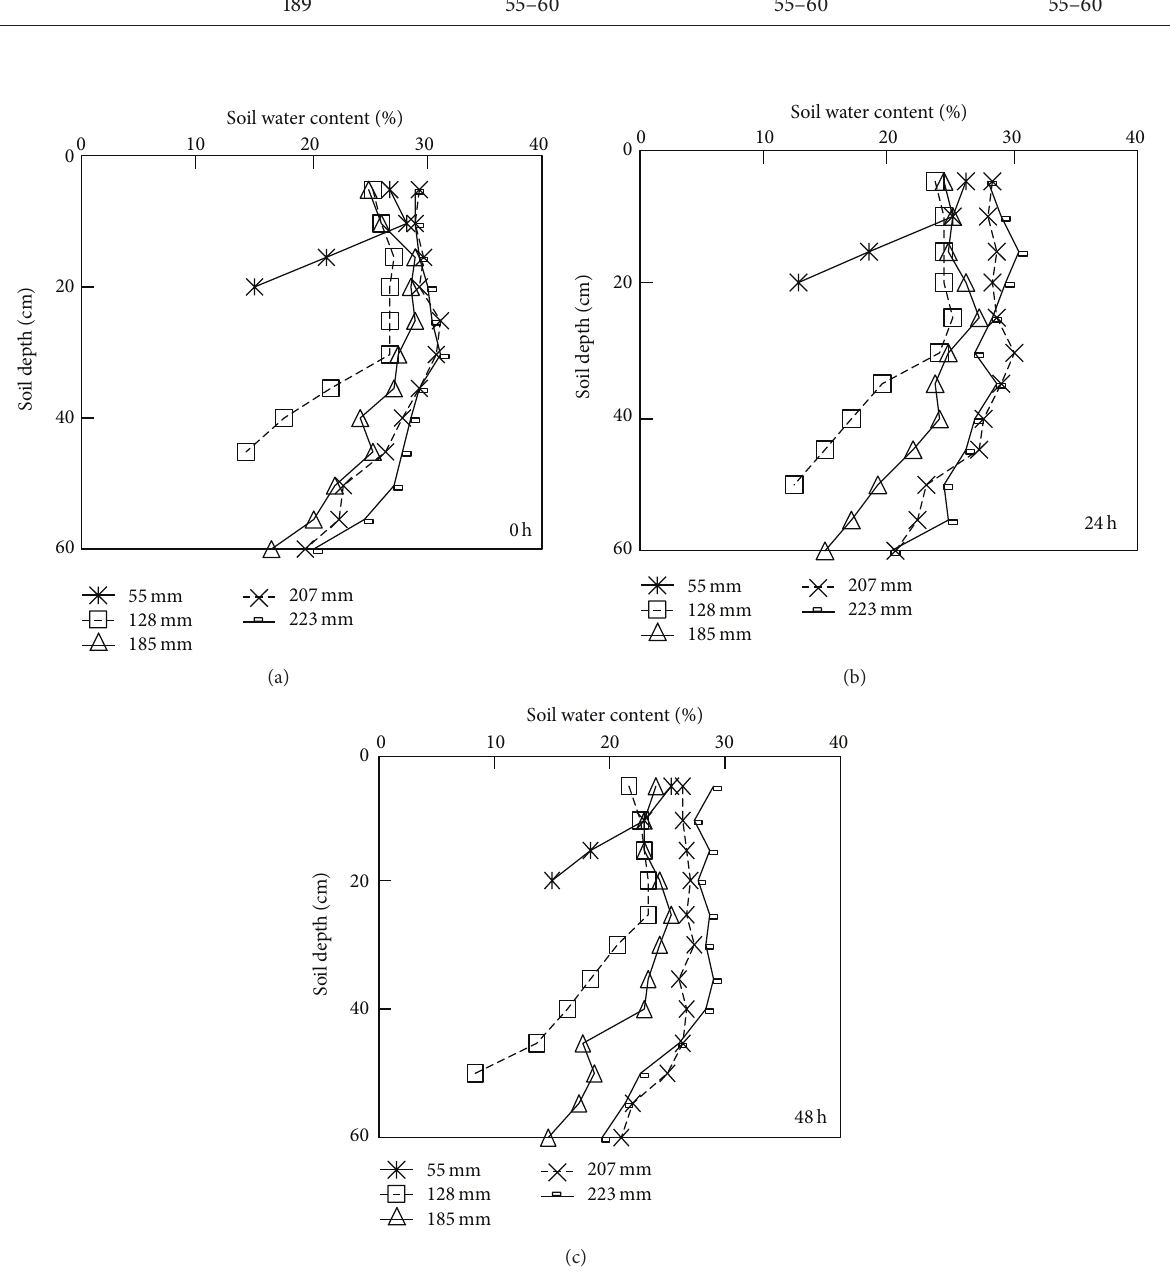
Figure 2: The depth distributions of soil water content at 0 hour (a), 24 hours (b), and 48 hours (c) during water redistribution under different water amounts